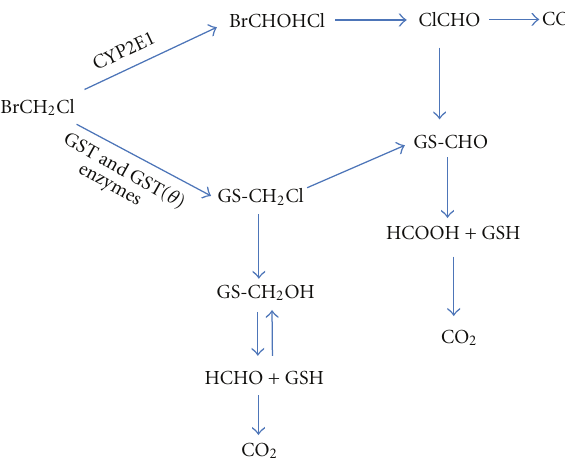
Figure 1: Schematic representation of BCM metabolism, adapted from